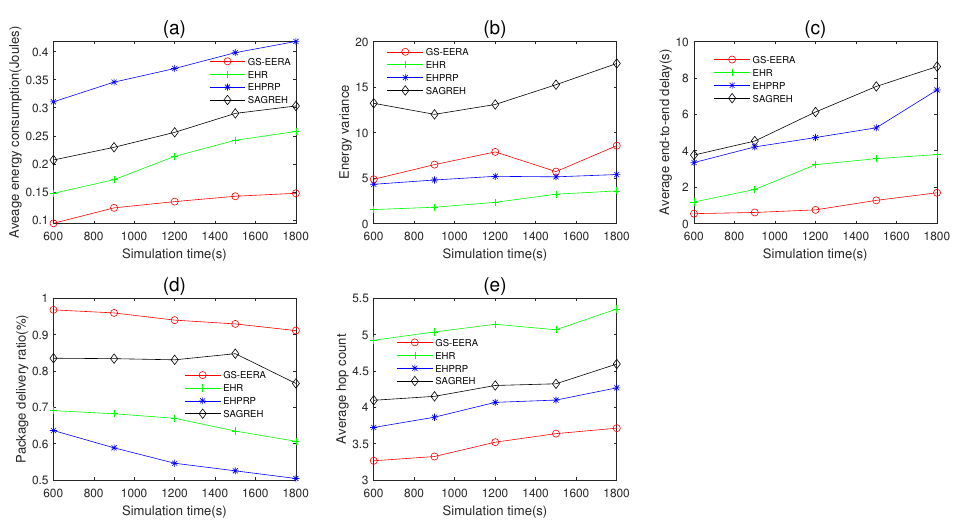
Figure 12. The impact of simulation time on ( a ) average energy consumption, ( b ) energy variance, ( c ) average end-to-end delay, ( d ) packet delivery ratio and ( e ) average hop